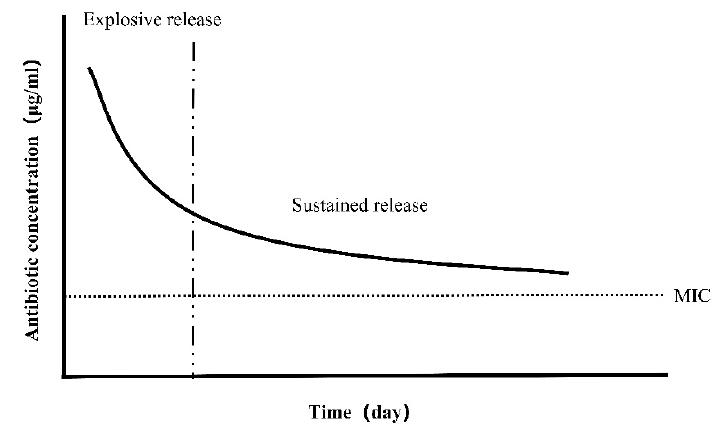
Figure 6. Ideal antibiotic release profile. The initial explosive release can kill bacteria effectively, and then the sustained release above the minimum inhibitory concentration (MIC) can maintain the antibacterial effect for a long period without antibiotic resistance.